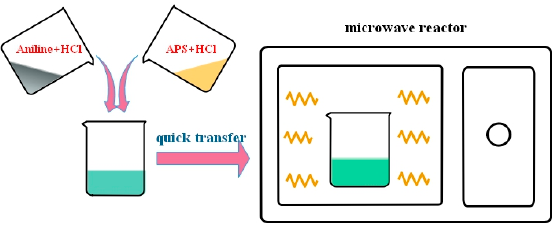
Scheme 1. Schematic for preparation of PANI with the microwave-assisted polymerization. Table 1. The feed compositions of reagents for preparing PANI samples 1 .